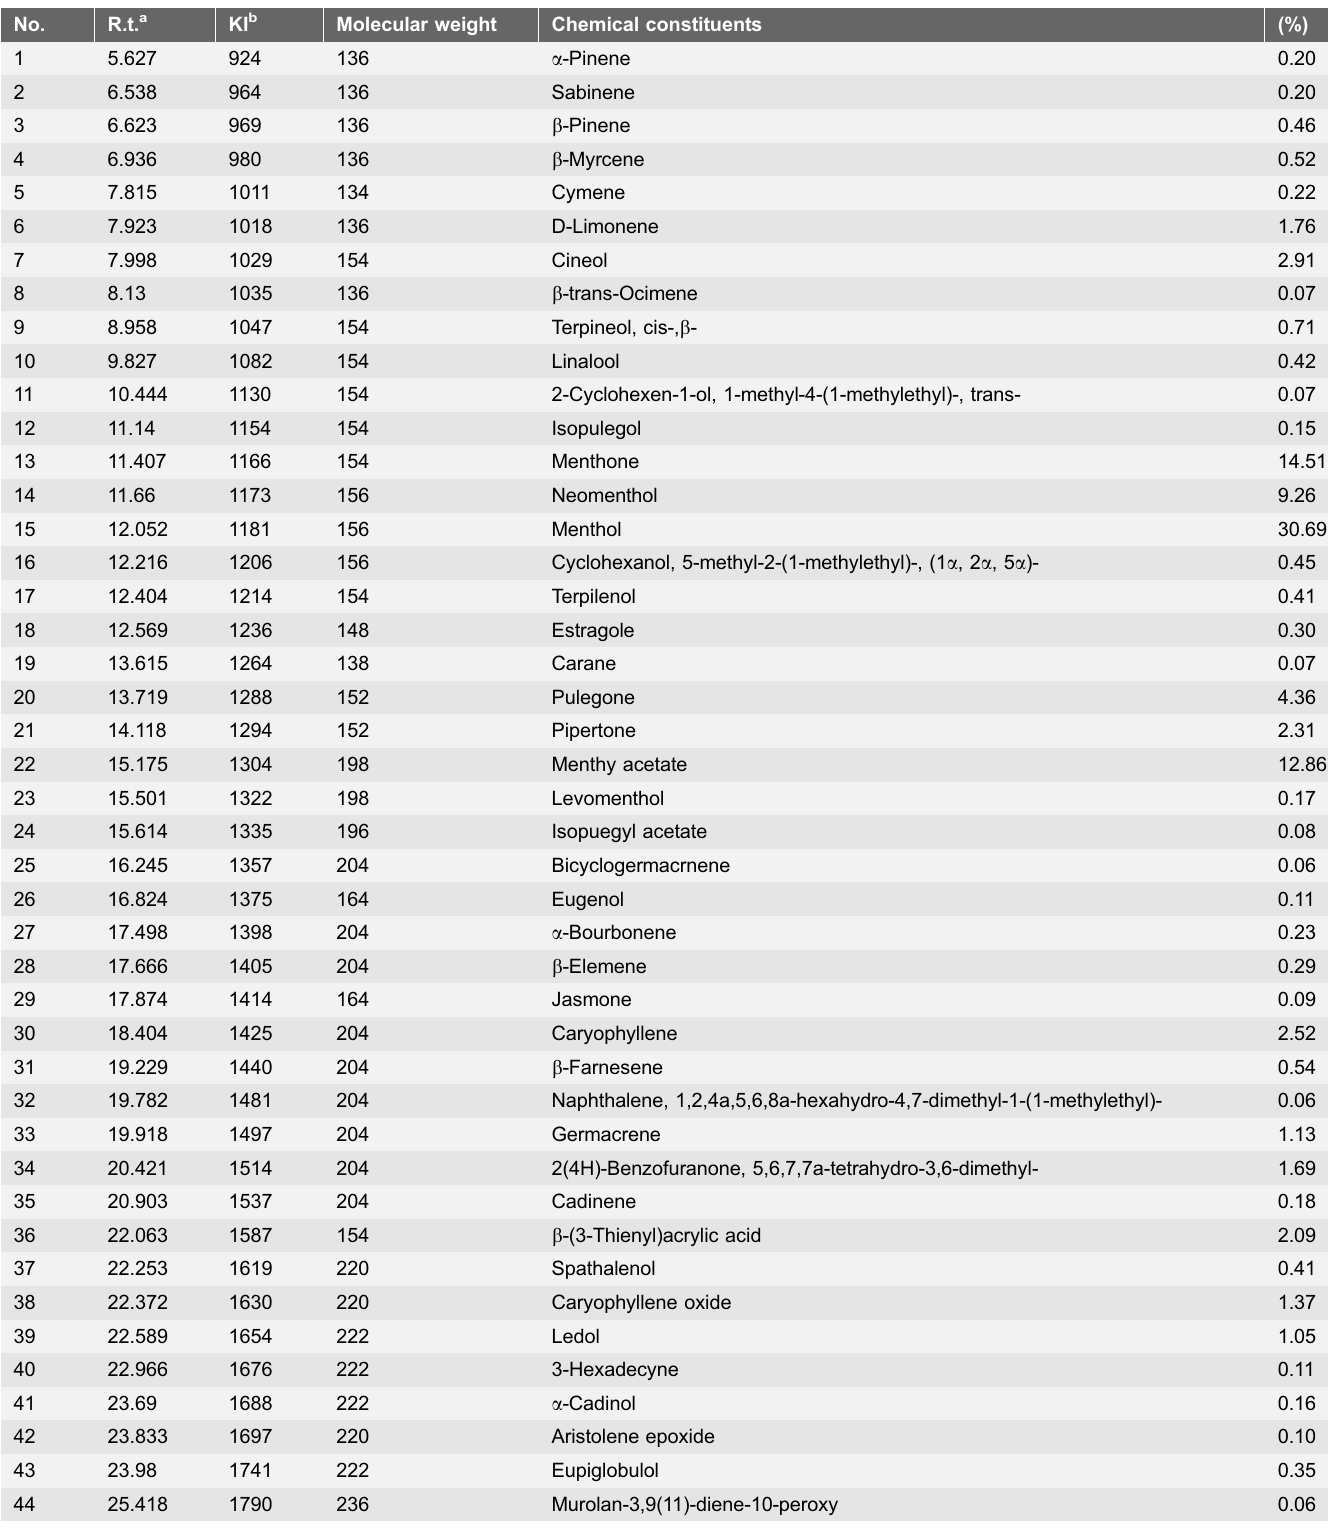
Table 1. Chemical composition of